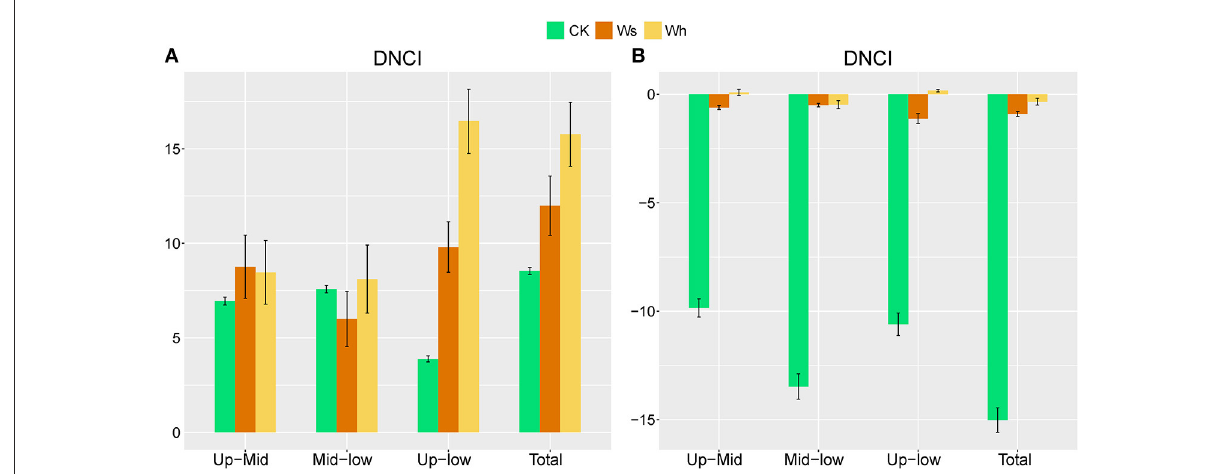
FIGURE5 Dispersal–niche continuum index (DNCI) of soil bacterial (A) and fungal (B) communities across soil layers. Means ± standard errors are shown in the figures. The main assembly process is either dispersal (DNCI < 0), niche (DNCI > 0), or dispersal–niche (DNCI ≈ 0). Ws, slight warming; Wh, high warming. Up, 0–10cm; Mid, 10–20cm; Low, 20–30cm.